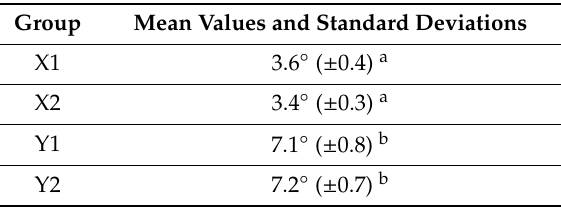
Table 1. Deviation from planned view: di ff erent superscript letters indicate statistical